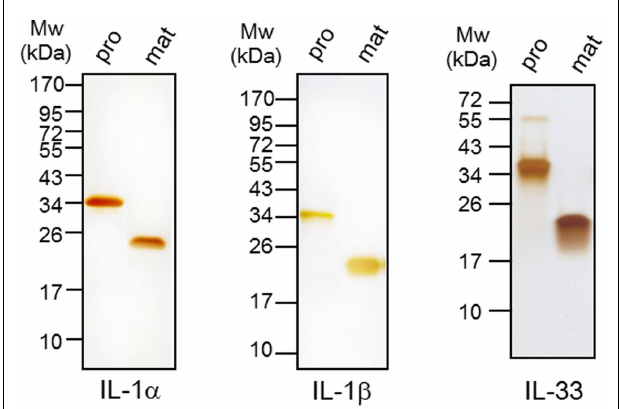
FIGURE 1 | Expression and purification of recombinant cytokines . Six different recombinant cytokine proteins were expressed in E. coli as indicated. Precursor (pro) IL-1 α and mature (mat) IL-1 α (200ng/lane) in left panel, proIL-1 β and mature IL-1 β (100ng/lane) in middle panel, and proIL-33 and mature IL-33 (500ng/lane) were purified by affinity chromatography and then subjected to 10% SDS-PAGE.The purity of each recombinant protein was visualized by silver staining.The data represents one of three independent